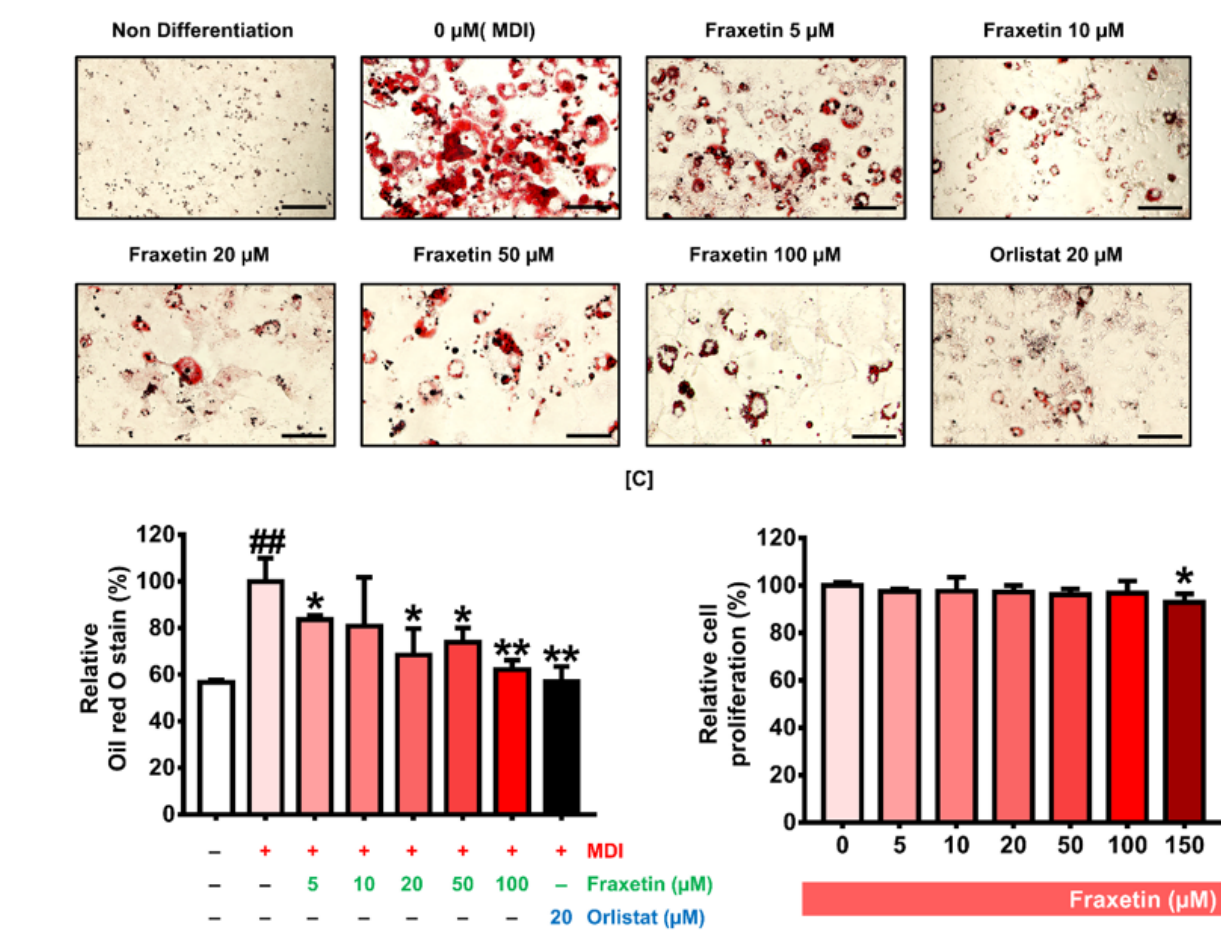
Figure 1. Impact of fraxetin on the formation of lipid droplets and proliferation of 3T3-L1 cells. ( A , B ) Nondifferentiated cells and mature adipocytes were incubated with different doses of fraxetin (0, 5, 10, 20, 50, and 100 µM). Relative lipid accumulation stained by oil red O was measured by a microplate reader at 490 nm of optical density. Orlistat (20 µ M) was treated as a positive control. Scale bar: 50 µm. The different colors in bar graph represent the different concentration of fraxetin. Black bar indicates orlistat. ( C ) Cell proliferation analysis was conducted in 3T3-L1 preadipocytes. All data were obtained in triplicate. The symbols “*” and “**” represent significant differences between the differentiated group and others (* p < 0.05, ** p < 0.01). “##” means considerable differences between the nondifferentiated group and others (## p < 0.01), as verified using one-way analysis of variance (ANOVA), followed by Dunnett’s post hoc analysis.